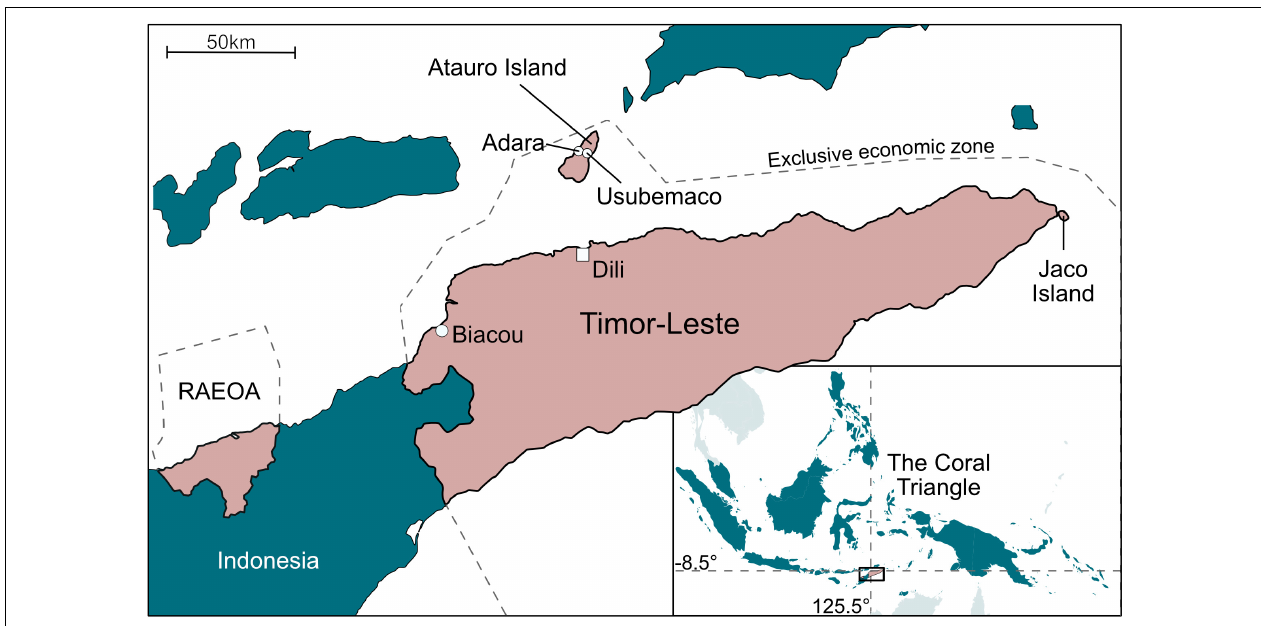
FIGURE 1 | Map illustrating Timor-Leste within the Coral Triangle region (inset). The main map shows the two case study locations where forms of co-management have been established, (a) Biacou community, and (b) Adara community located on the Island of Atauro, in relation to the capital, Dili and the Special Administrative Region of Oecusse-Ambeno (RAEOA). The dotted line represents the